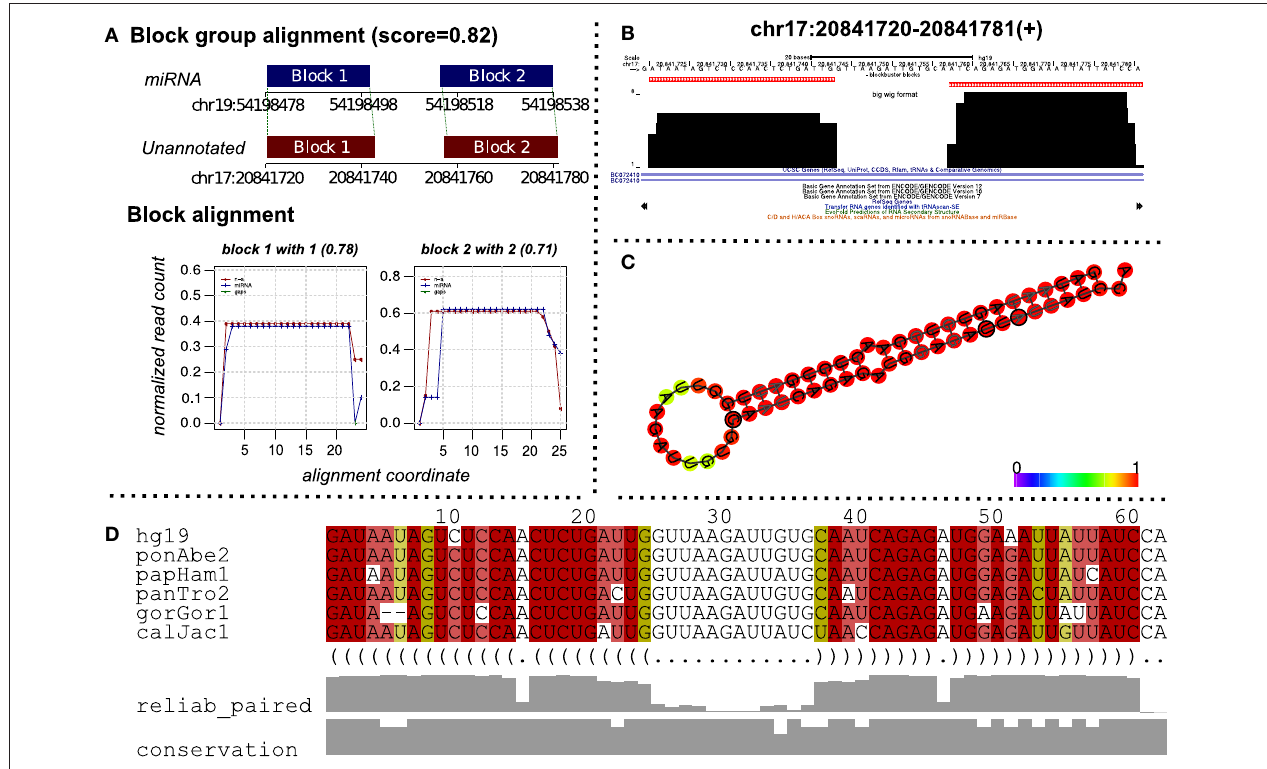
FIGURE 5 | A putative miRNA predicted by alignment of read profiles. (A) Alignment between an unannotated and miRNA read profile (block group) computed using deepBlockAlign . The alignment is obtained while aligning unannotated read profiles from ENCODE dataset against the miRRPdb. The unannotated region has a similar read profile to that of miRNA characterized by similar arrangement of reads as evident from block alignment and similar size and distance between the read blocks, leading to a high alignment score of 0.82. (B) The read profile for the